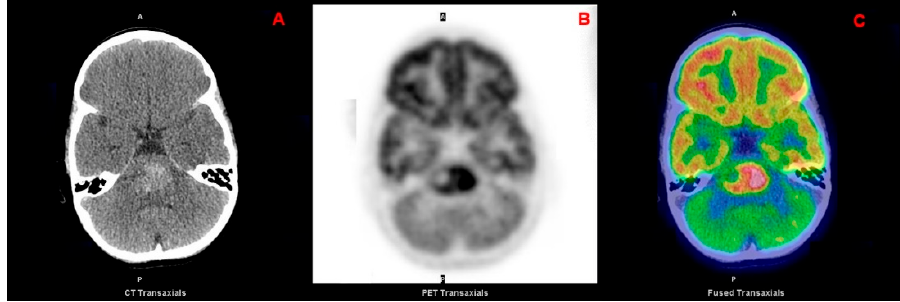
Figure 2. Transaxial CT ( A ), PET ( B ) and fused PET/CT ( C ) images of a pontine glioma.